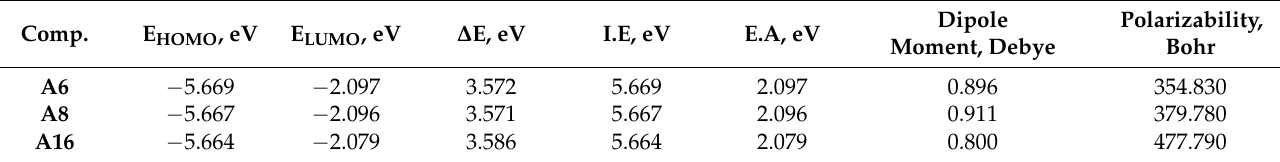
Table 3. HOMO energy, LUMO energy, orbital energy gap, ionization energy, electron affinity, dipole moment and polarizability calculated at B3LYP/6-311g(d,p)